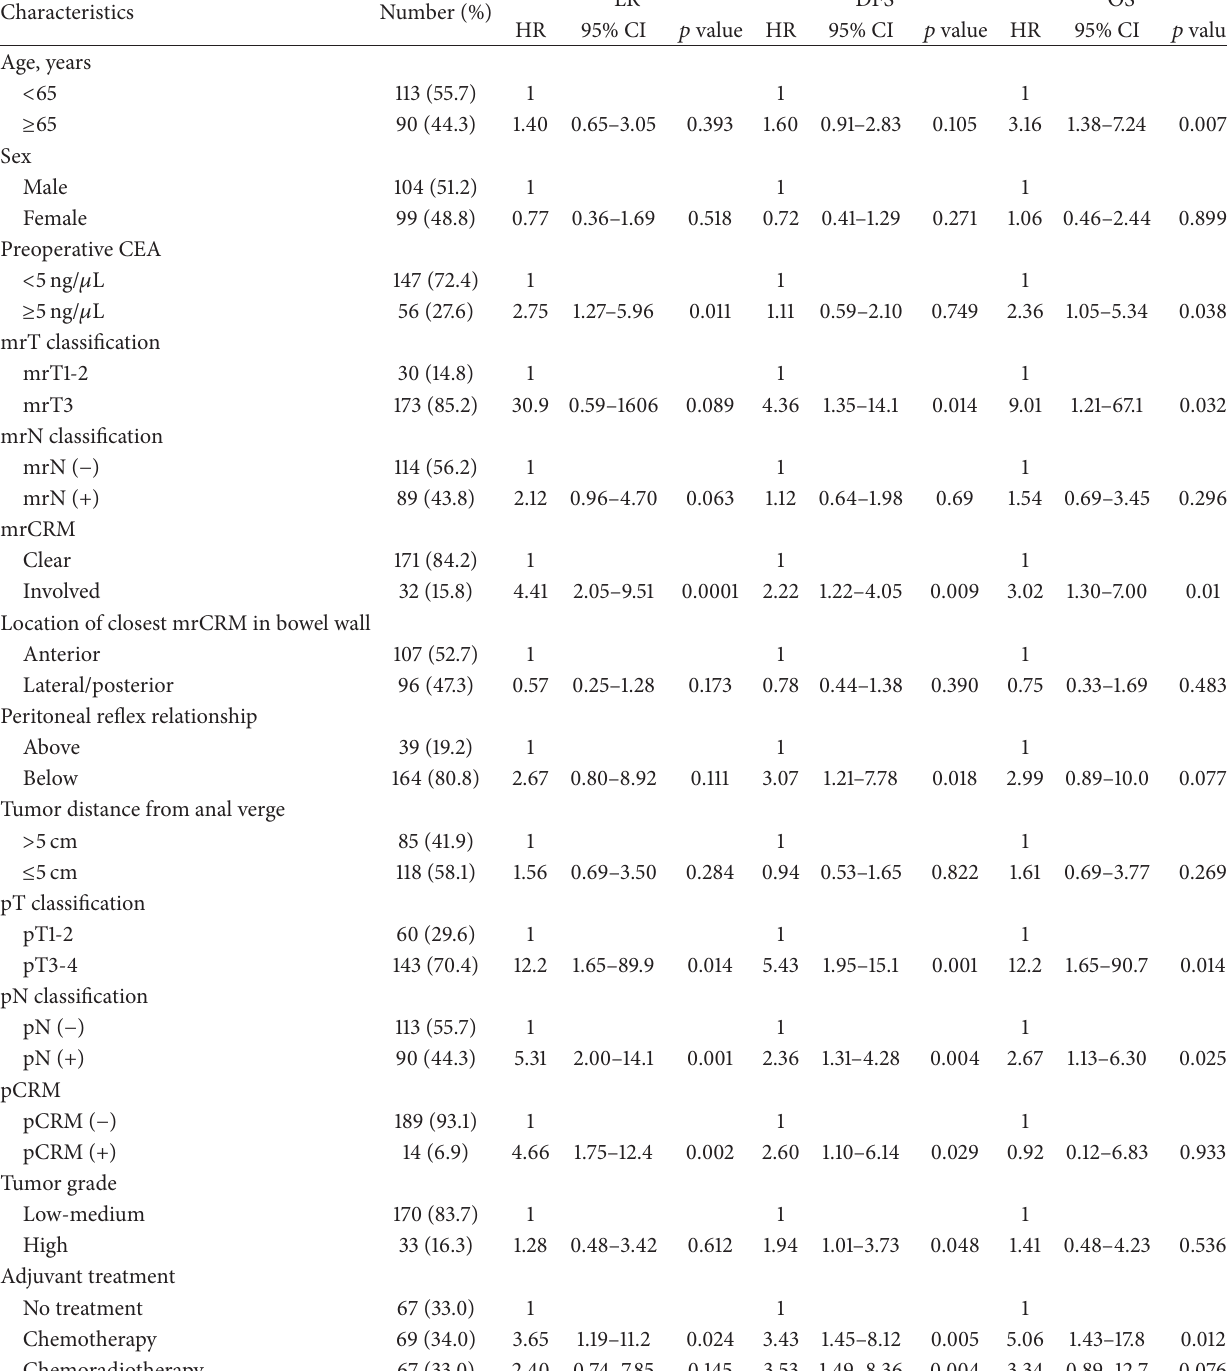
Table 2: The association between radiological and clinicopathological characteristics and patients’